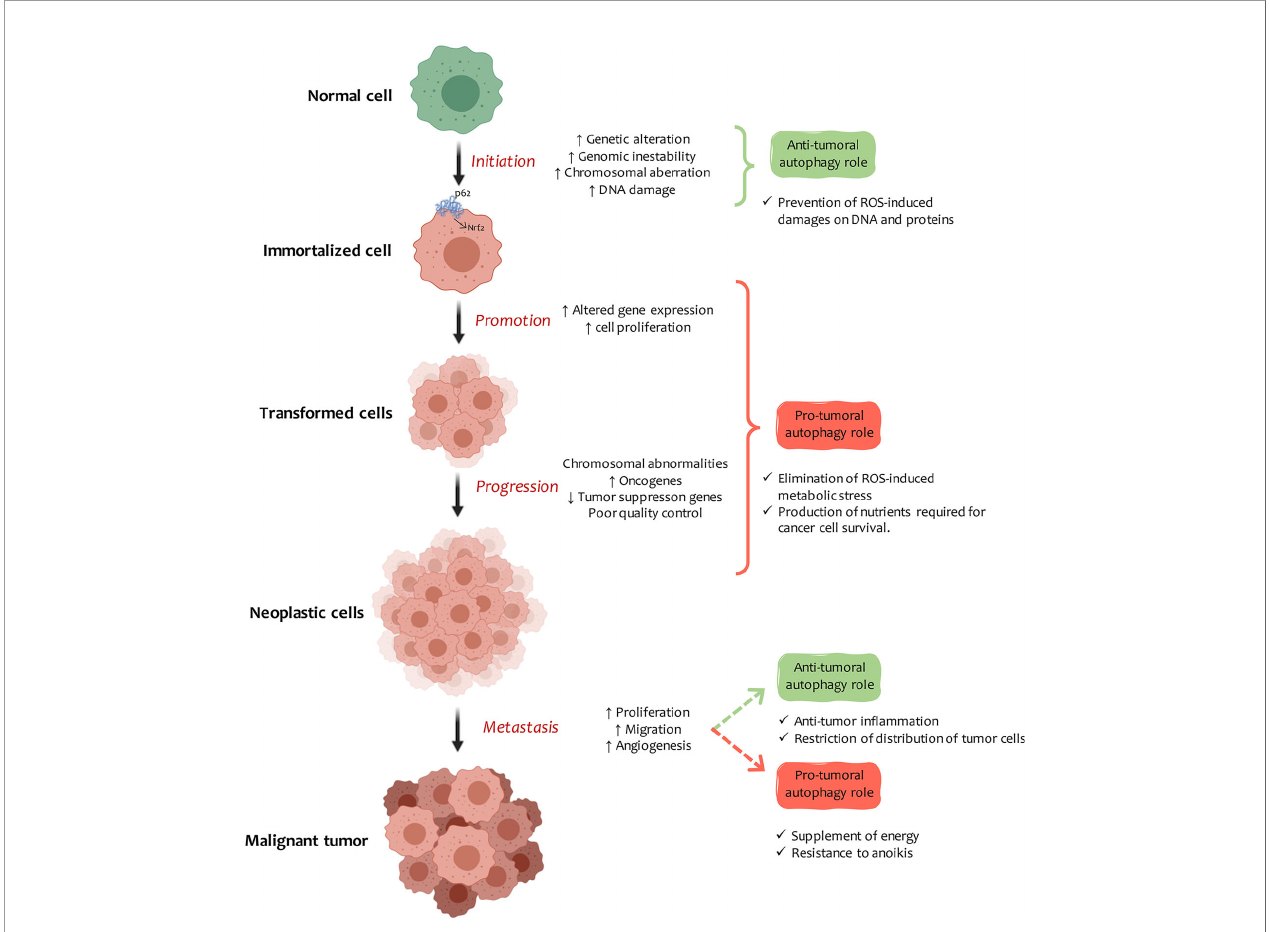
FIGURE 2 | Autophagy and cancer. Autophagy plays a dual role in the development of cancer, the nature of which depends on the tissue, stage, and type of tumor. In carcinogenesis early stage, autophagy induction protects cells from DNA and protein damage due to the indiscriminate increase in ROS and cell-toxic components. Once cells are immortalized, autophagy plays an essential role in promoting tumors. Autophagy induction can be modi fi ed, or at least some of the steps involved in the mechanism can be changed. The excessive accumulation of autophagic vesicles leads to p62 molecule accumulation and intracellular signaling activation, which leads to Nrf2 transformation, in fl ammation, and cell necrosis. In tumor progression, autophagy provides high-energy nutrients to actively dividing transformed cells. When transformed cells metastasize, autophagy can inhibit the process by promoting anti-tumor in fl ammatory responses or by restricting the expansion of dormant metastatic tumor cells. On the contrary, it supports metastasis by improving cell fi tness against a stressful microenvironment